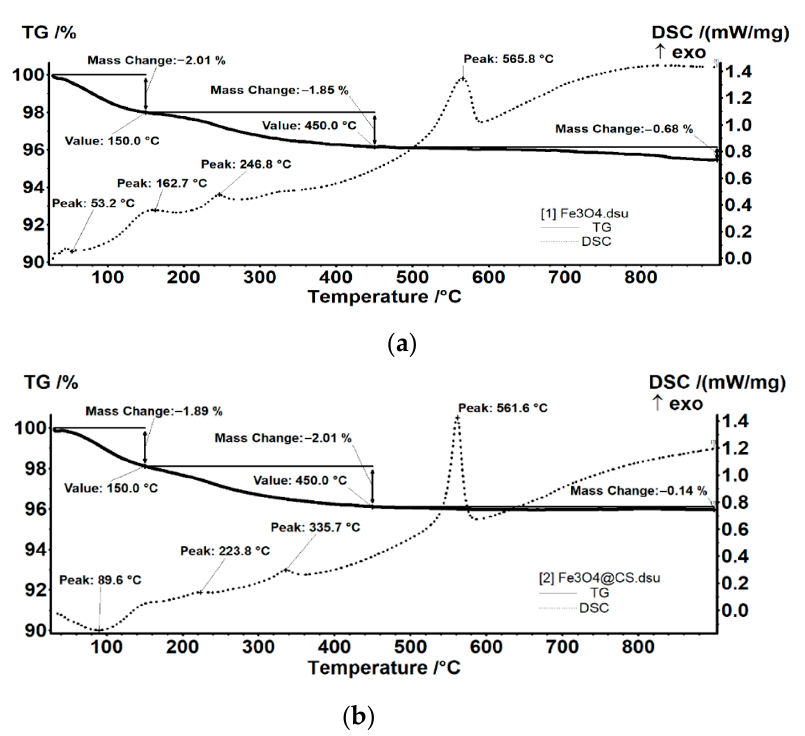
Figure 4. Thermogravimetric analysis of ( a ) Fe 3 O 4 and ( b ) Fe 3 O 4 @CS